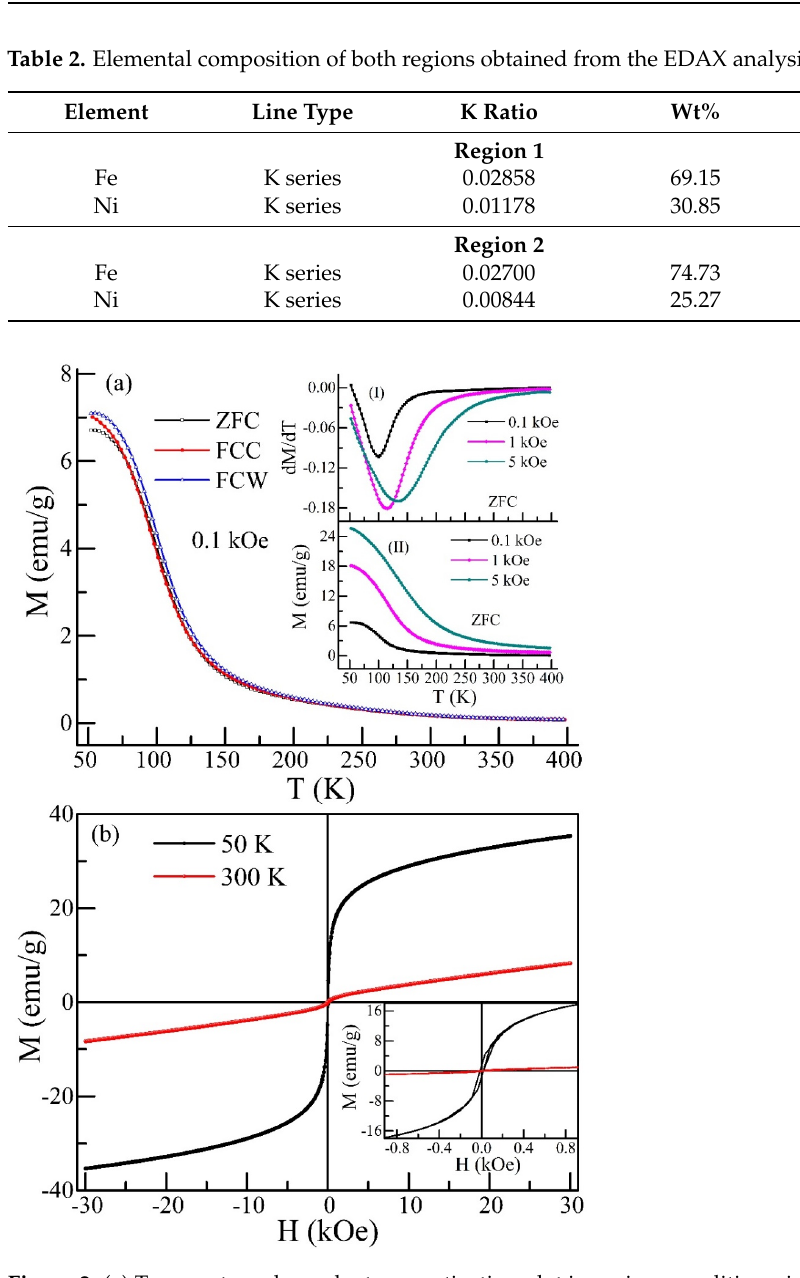
Figure 2. ( a ) Temperature-dependent magnetization plot in various conditions, i.e., zero-field-cooled cooling (ZFC), field-cooled cooling (FCC) and field-cooled warming (FCW) of Fe 65 Ni 35 alloy. Inset I : M-T plot at different fields. Inset II : Derivative of M-T plot at different fields. ( b ) Magnetic hysteresis loop at 50 K and 300 K for Fe 65 Ni 35 . Inset : M-H plot enlarged view to see the magnetic